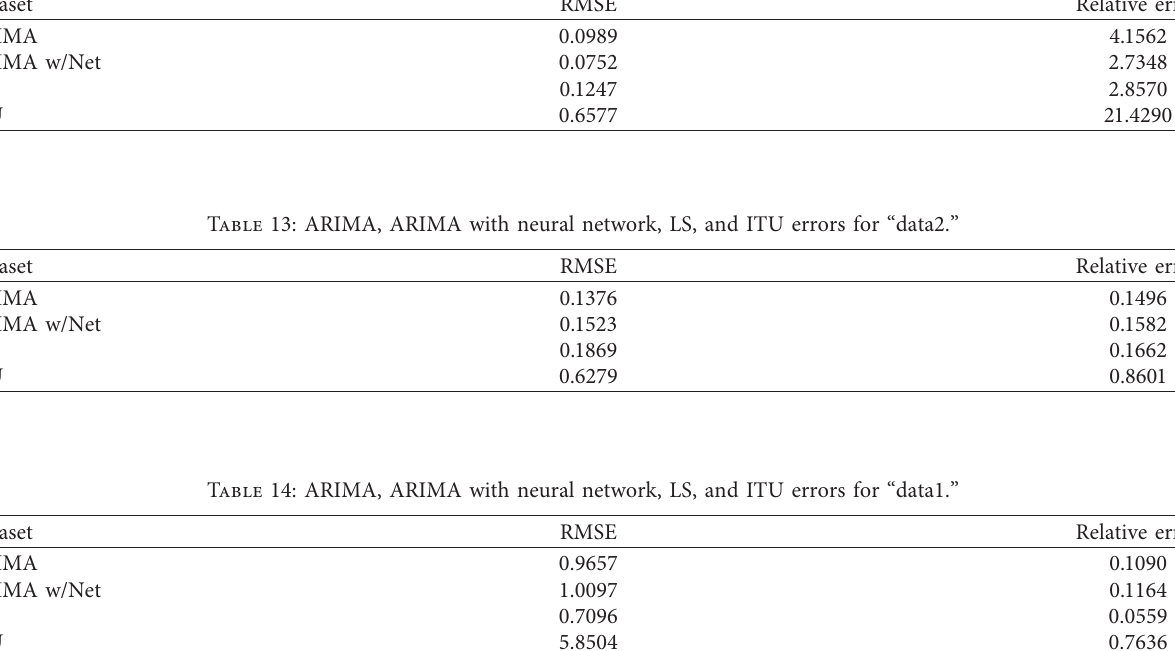
Figure 15: Comparison between measured data, ITU estimation, LS estimation, and proposed modelling curves for (a) “data3” subscenario, (b) “data2” subscenario, and (c) “data1” subscenario.